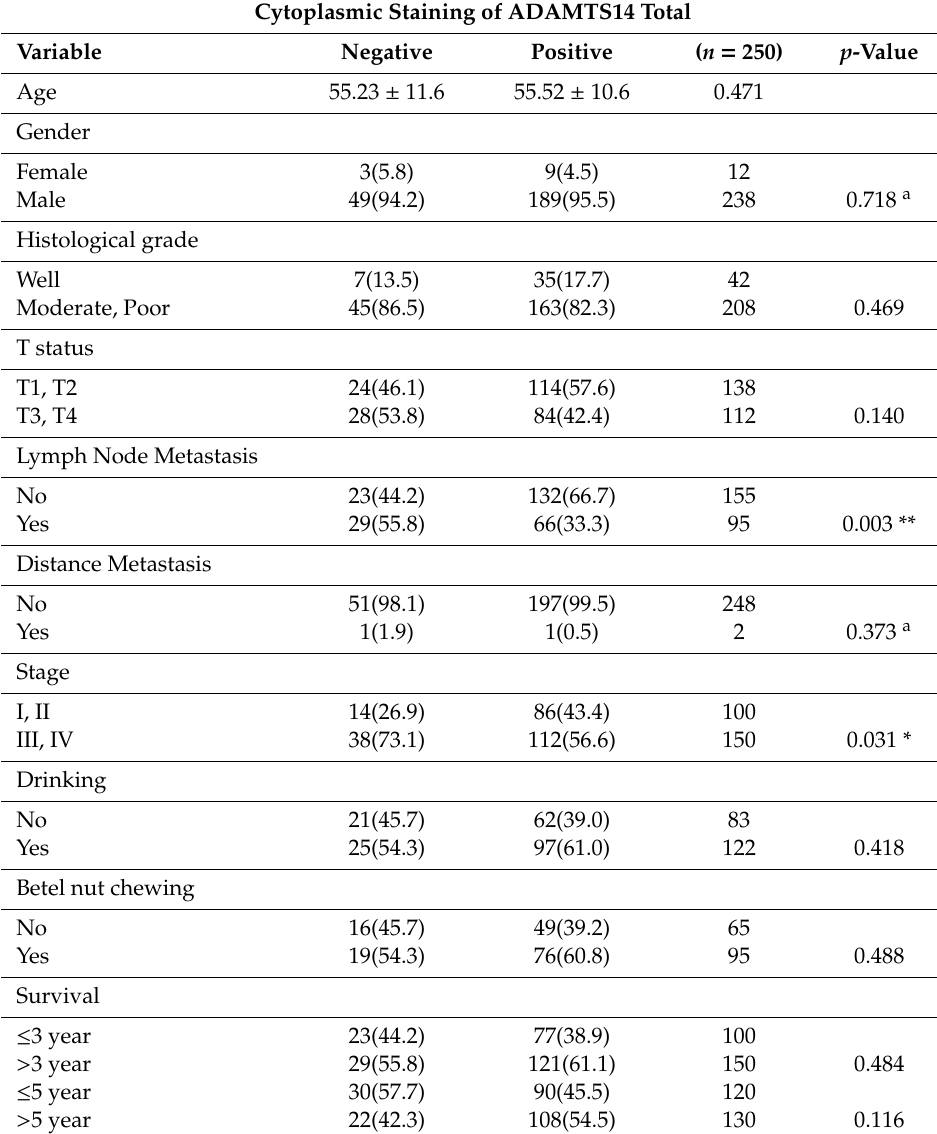
Table 2. Clinicopathologic factors associated with ADAMTS14